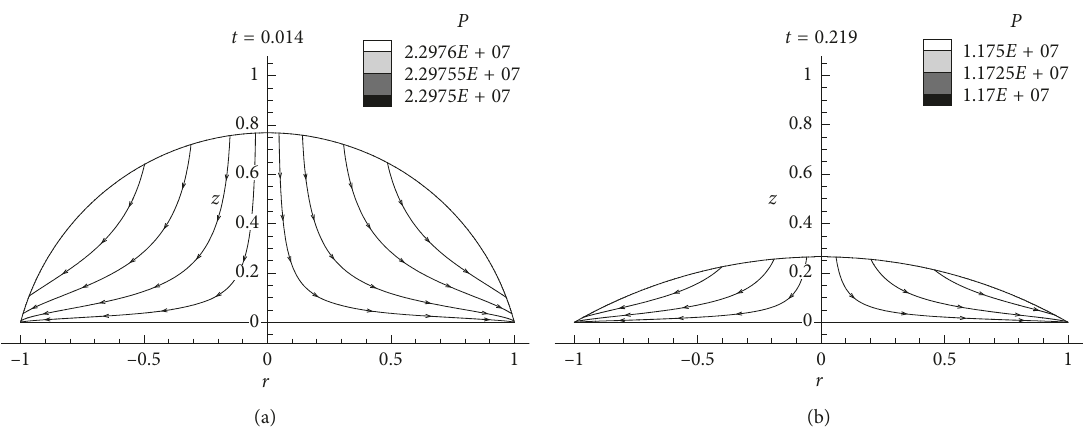
Figure 3: Flow profile inside the drop phase. Initial AR � 0.8, Ca � 8.41 × 10 − 8 .